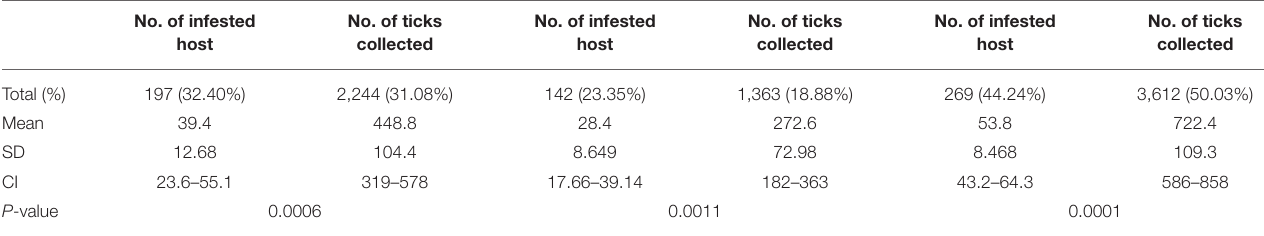
TABLE 3 | District wise spatial distribution of infested hosts (domestic fowl) and collected ticks ( Argas persicus ). No. of infested